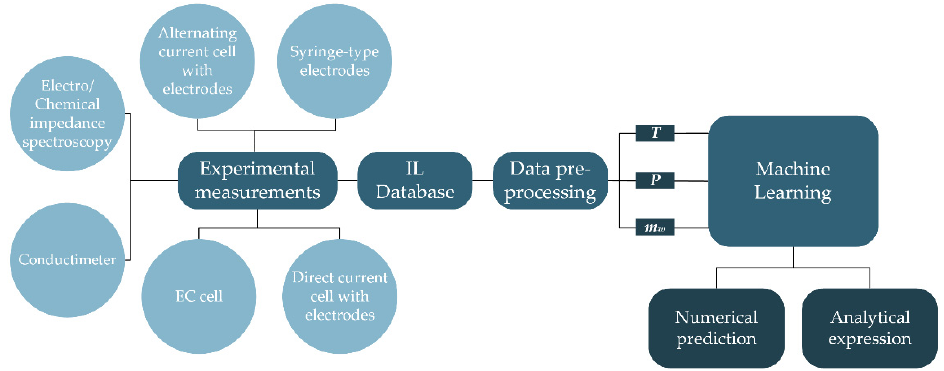
Figure 1. Machine learning model for electrical conductivity prediction, providing both numerical and analytical